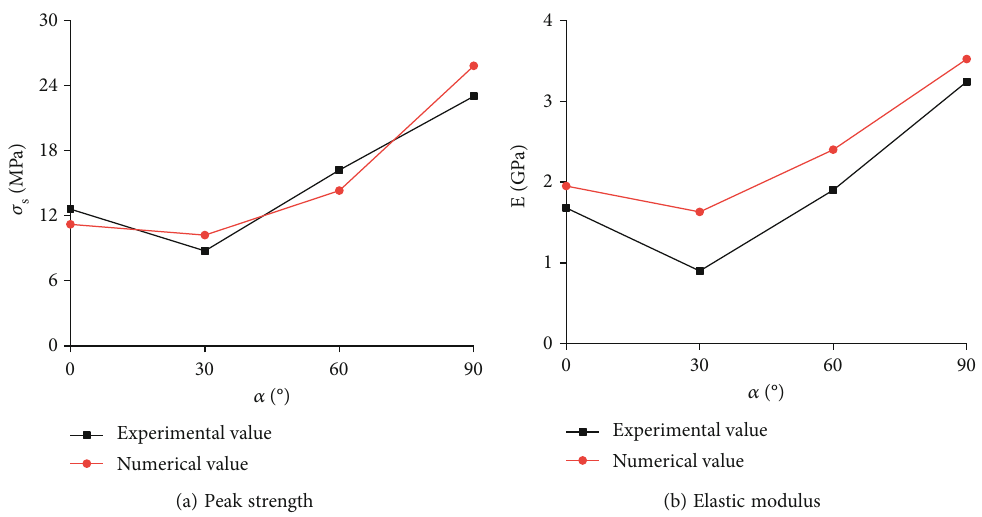
Figure 3: Comparison between the numerical results and experimental results.